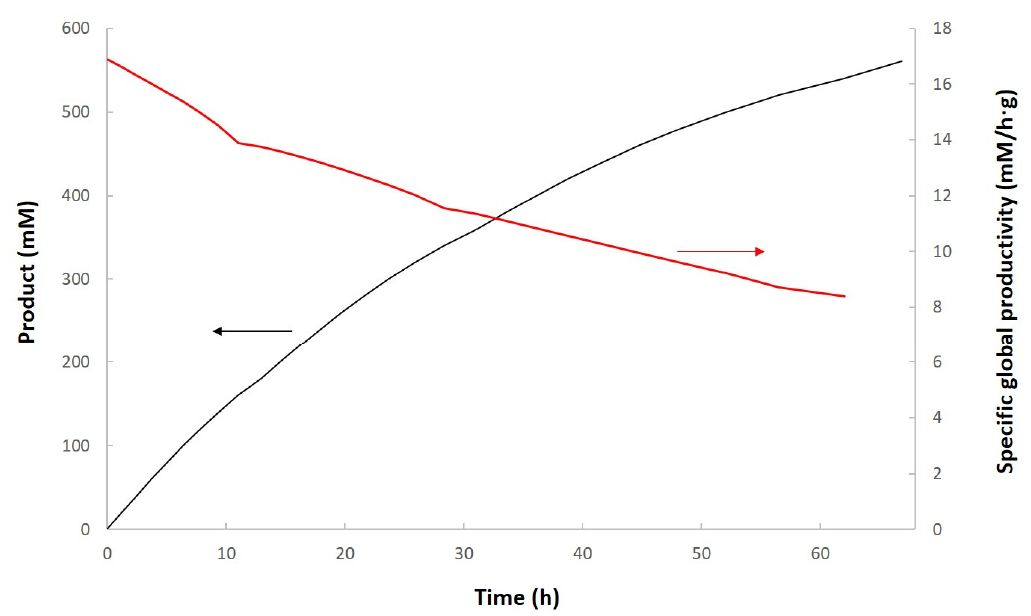
Figure 4. Product and specific global productivity over time during the operation of the successive batch enzyme reactor with monophasic first-order inactivation kinetics, k d = 0.022 h. Black line— Product (mM); Red line—specific global productivity (mM/h·g biocat ).